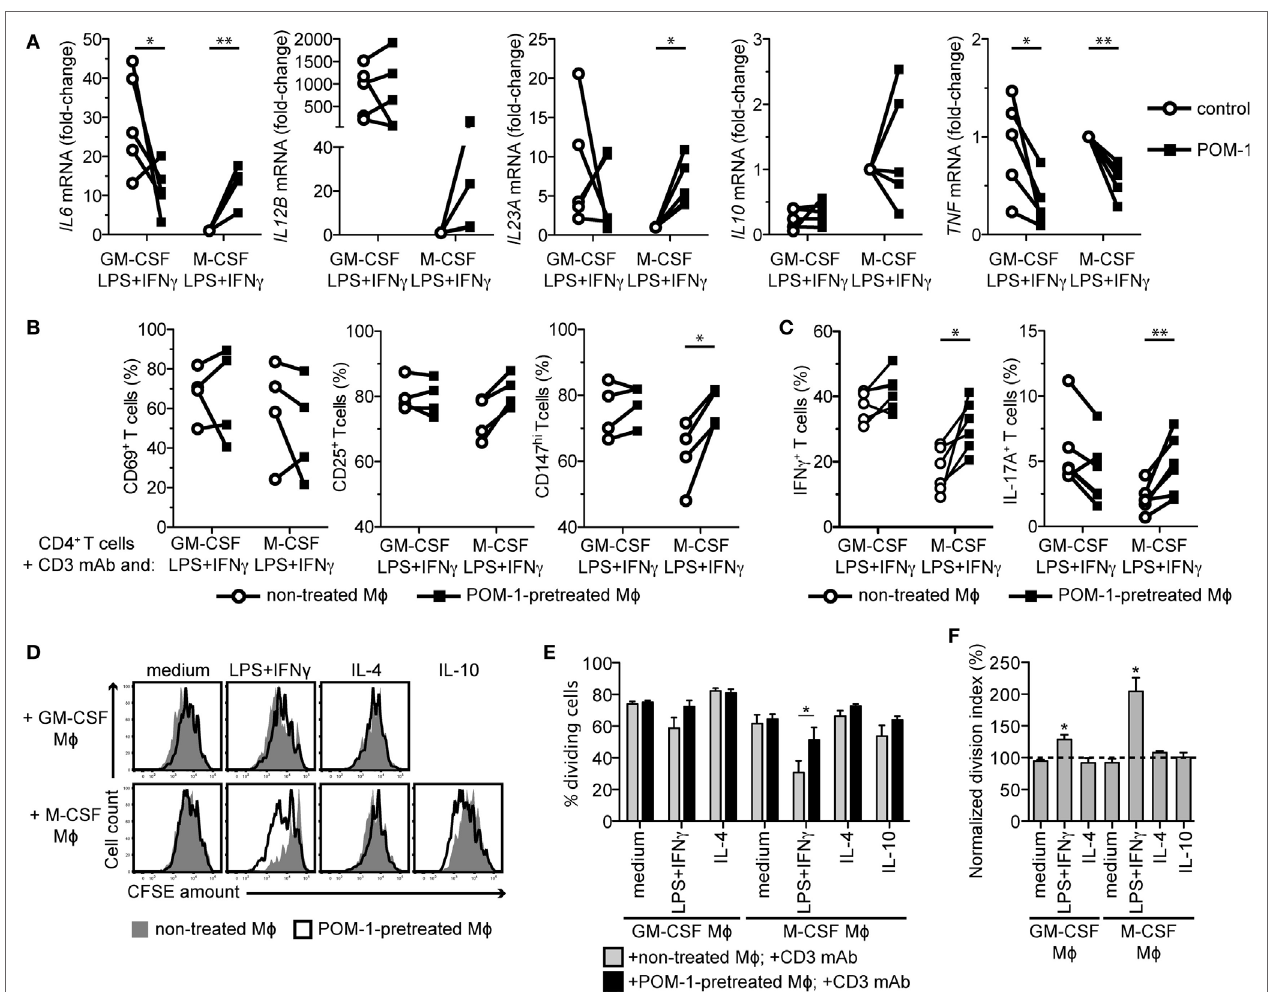
FigUre 6 | CD39 blockade by POM-1 mitigates the immunosuppressive phenotype of M-CSF-dependent LPS + IFN γ -activated macrophages (M ϕ s). (a) Human M ϕ s were differentiated for 7 days with GM-CSF or M-CSF and then activated for 2 days with LPS + IFN γ in the absence (control) or presence of 20 µM POM-1. Expression of the cytokine genes was then analyzed by qRT-PCR. To compare gene expression, the data were normalized to the mRNA levels in the M-CSF LPS + IFN γ -stimulated M ϕ s that were set to one. Data represent five different donors. Statistical significance was assessed by unpaired